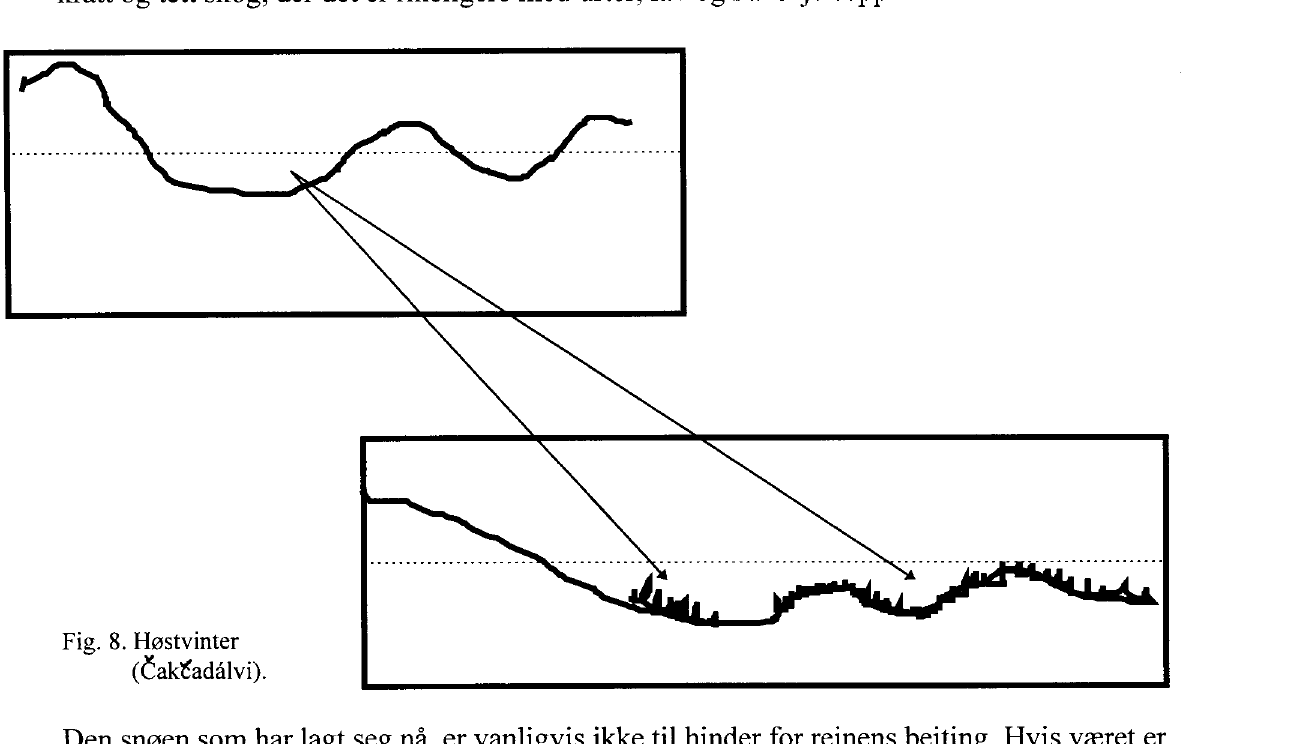
Fig. 8. Høstvinter